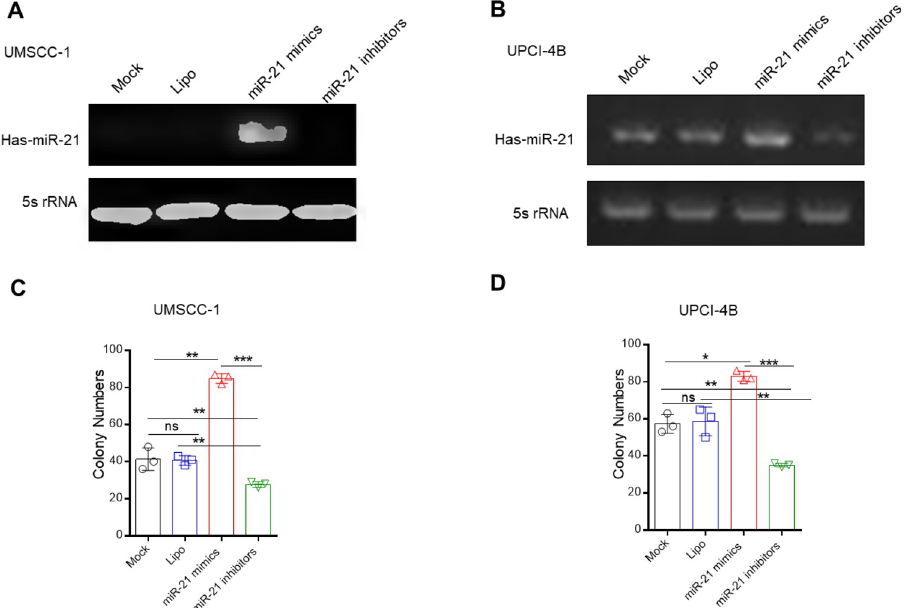
Fig 3. The clonogenic assay showed that miR-21 can enhance cell proliferation. (A) and (B) The miR-21 transfection efficiency was assessed by PCR in UMSCC-1 and UPCI-4B cells, respectively. (C) and (D) Clonogenic assays were performed to examine the effects of miR-21 in both cell lines. � , P < 0.05; �� , P < 0.01; ��� , P < 0.001. ns, nonsignificant.